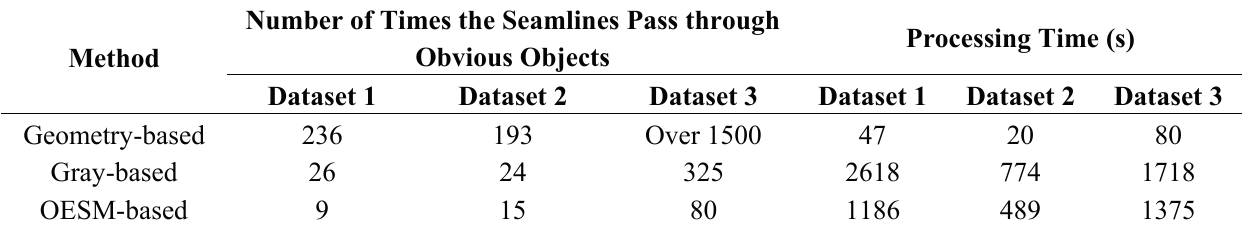
Table 2. Comparison of the results of the different